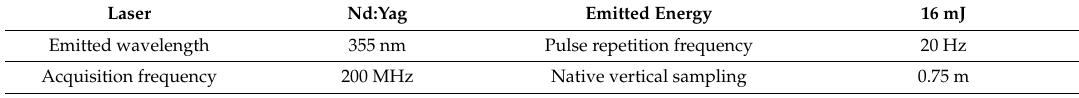
Table 3. Lidar for Atmospheric Surveys using Raman Scattering (LAASURS) main characteristics.